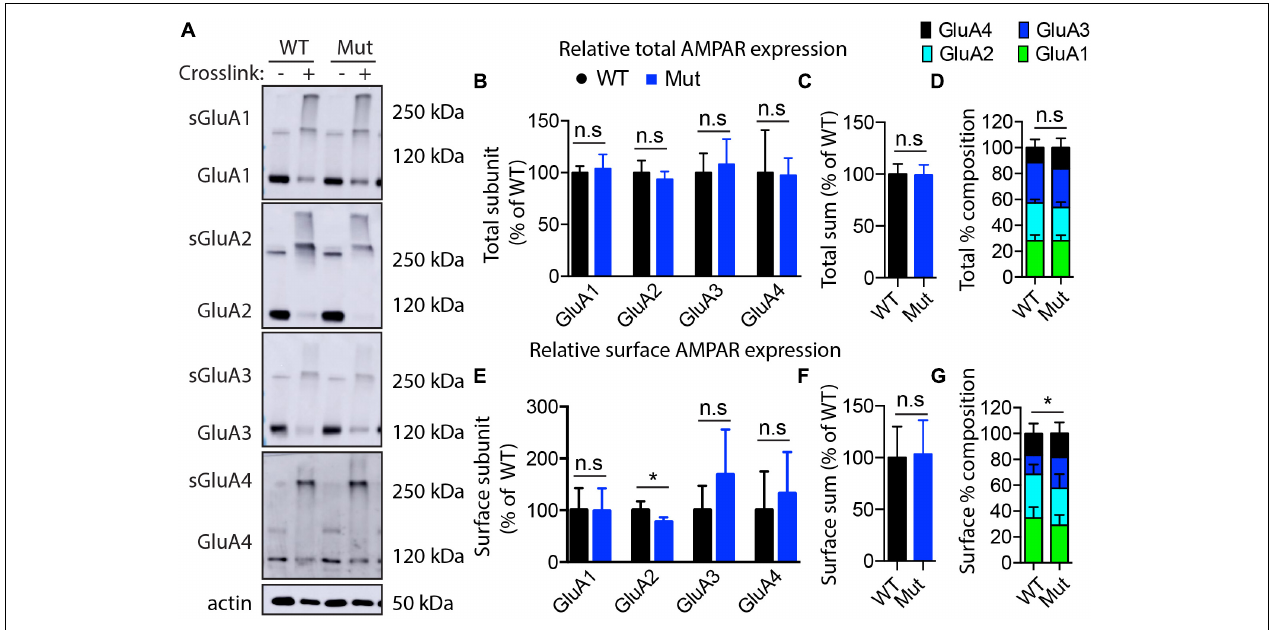
FIGURE 6 | Assessment of AMPA receptor subunits by surface cross-linking. (A) Representative images of immunoblots after BS 3 -crosslinking of samples to assess surface (crosslinking “+”) and total protein expression of AMPA receptors (crosslinking “ − ”). Actin was used for normalization. (B) Quantification of relative total protein levels of AMPA receptor subunits in samples not crosslinked. Signal intensities normalized to actin signal and wild type as 100%. (C) Quantification of total sum of all AMPA receptor subunits in samples not crosslinked. (D) Quantification of AMPA receptor subunit percentage composition in samples not crosslinked. (E) Quantification of relative surface protein levels of AMPA receptor subunits in samples treated with BS 3 (crosslinking “+”). Surface protein indicated by “s”on the blots in (A) Signal intensities of the bands at 250 kDa and above were normalized to actin signal and wild type as 100%. (F) Quantification of total sum of all AMPA receptor subunits at the membrane surface. (G) Quantification of surface AMPA receptor subunit percentage composition (significant differences in GluA2 composition). Optical densitometry quantification values represent the mean ± SEM ( n = 4–5, ∗ p < 0.05, n.s. p > 0.05, t -test, two-tailed).